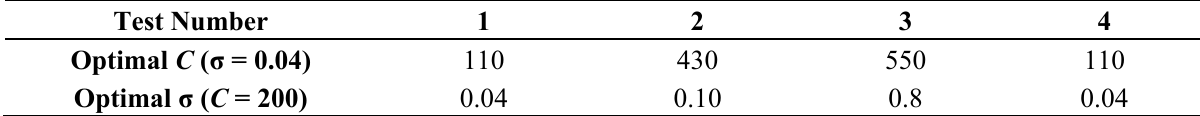
Table 1. The optimal parameters for different training and test sampling. Test Number 1 Optimal C ( σ =